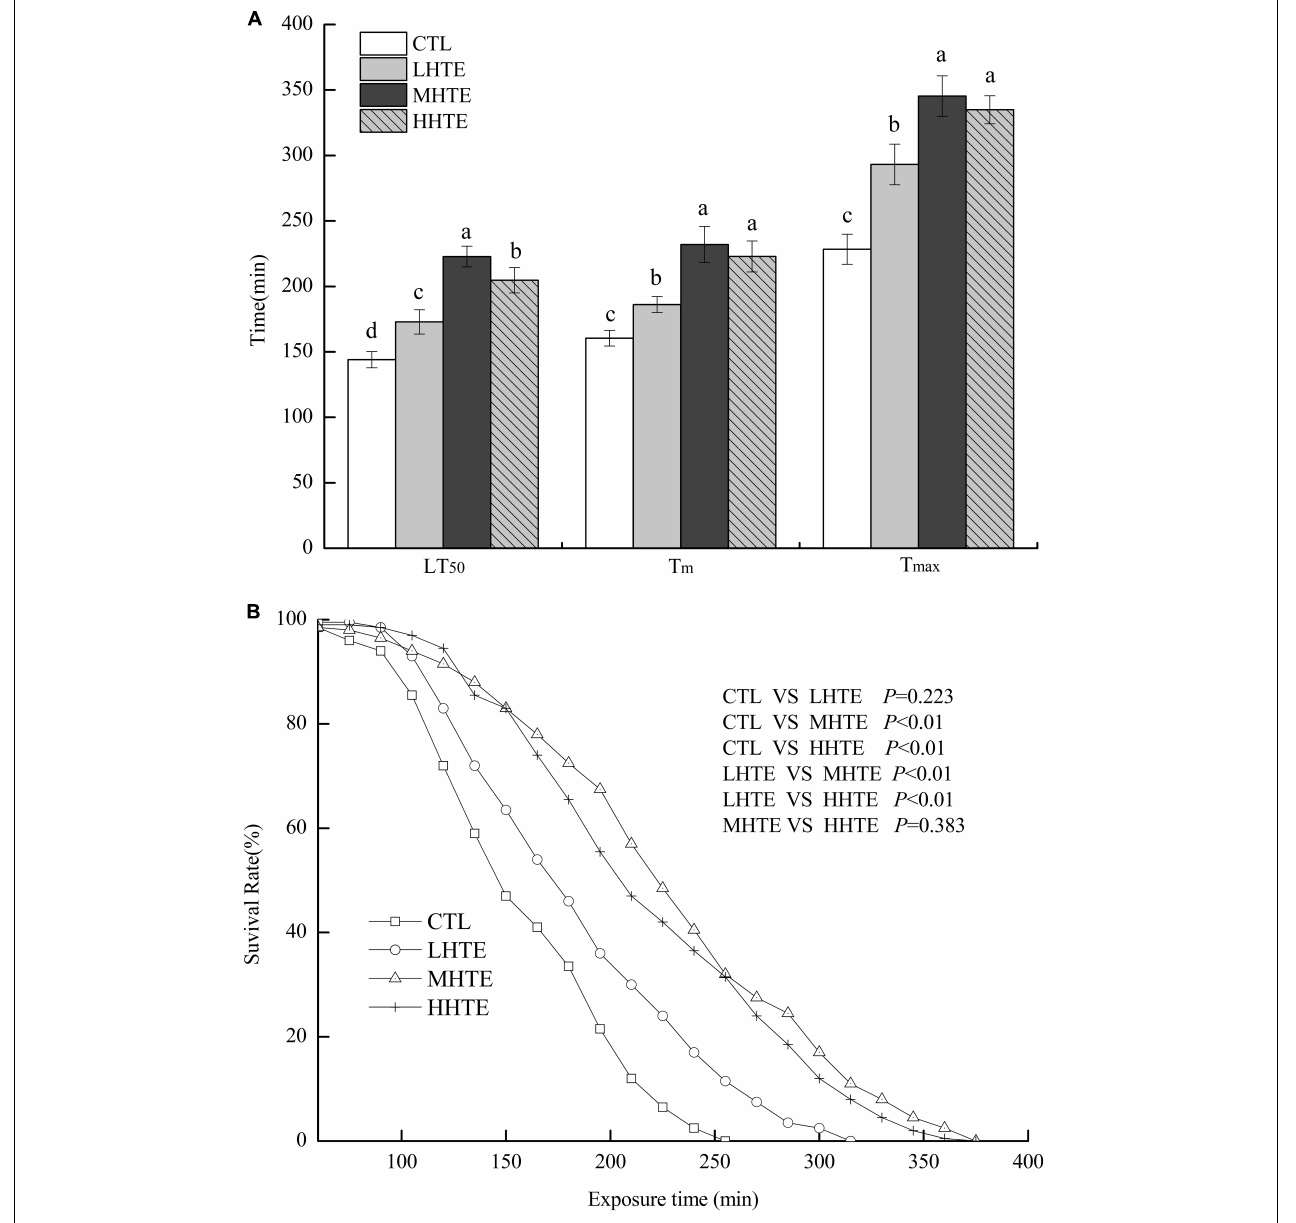
FIGURE 4 | The lethal time of 50% (LT 50 ), mean survival time (T m ), and maximum survival time (T max ) (A) and survival curves (B) of female flies under thermal stress fed a diet containing hsian-tsao extract (HTE) at low, medium, or high concentrations (LHTE, MHTE, or HHTE) or a non-HTE control diet (CTL) (150 female flies per group, 50 per replicate). Data show mean ± SD. Different lowercase letters indicate significant differences between groups (LSD test after one-way ANOVA, P <